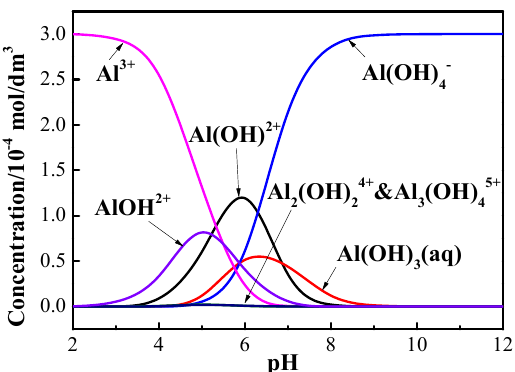
Figure 7. Effect of pH on species distribution diagrams of Al (III) ions at concentration of 3.0 × 10 − 4 mol/dm 3 .